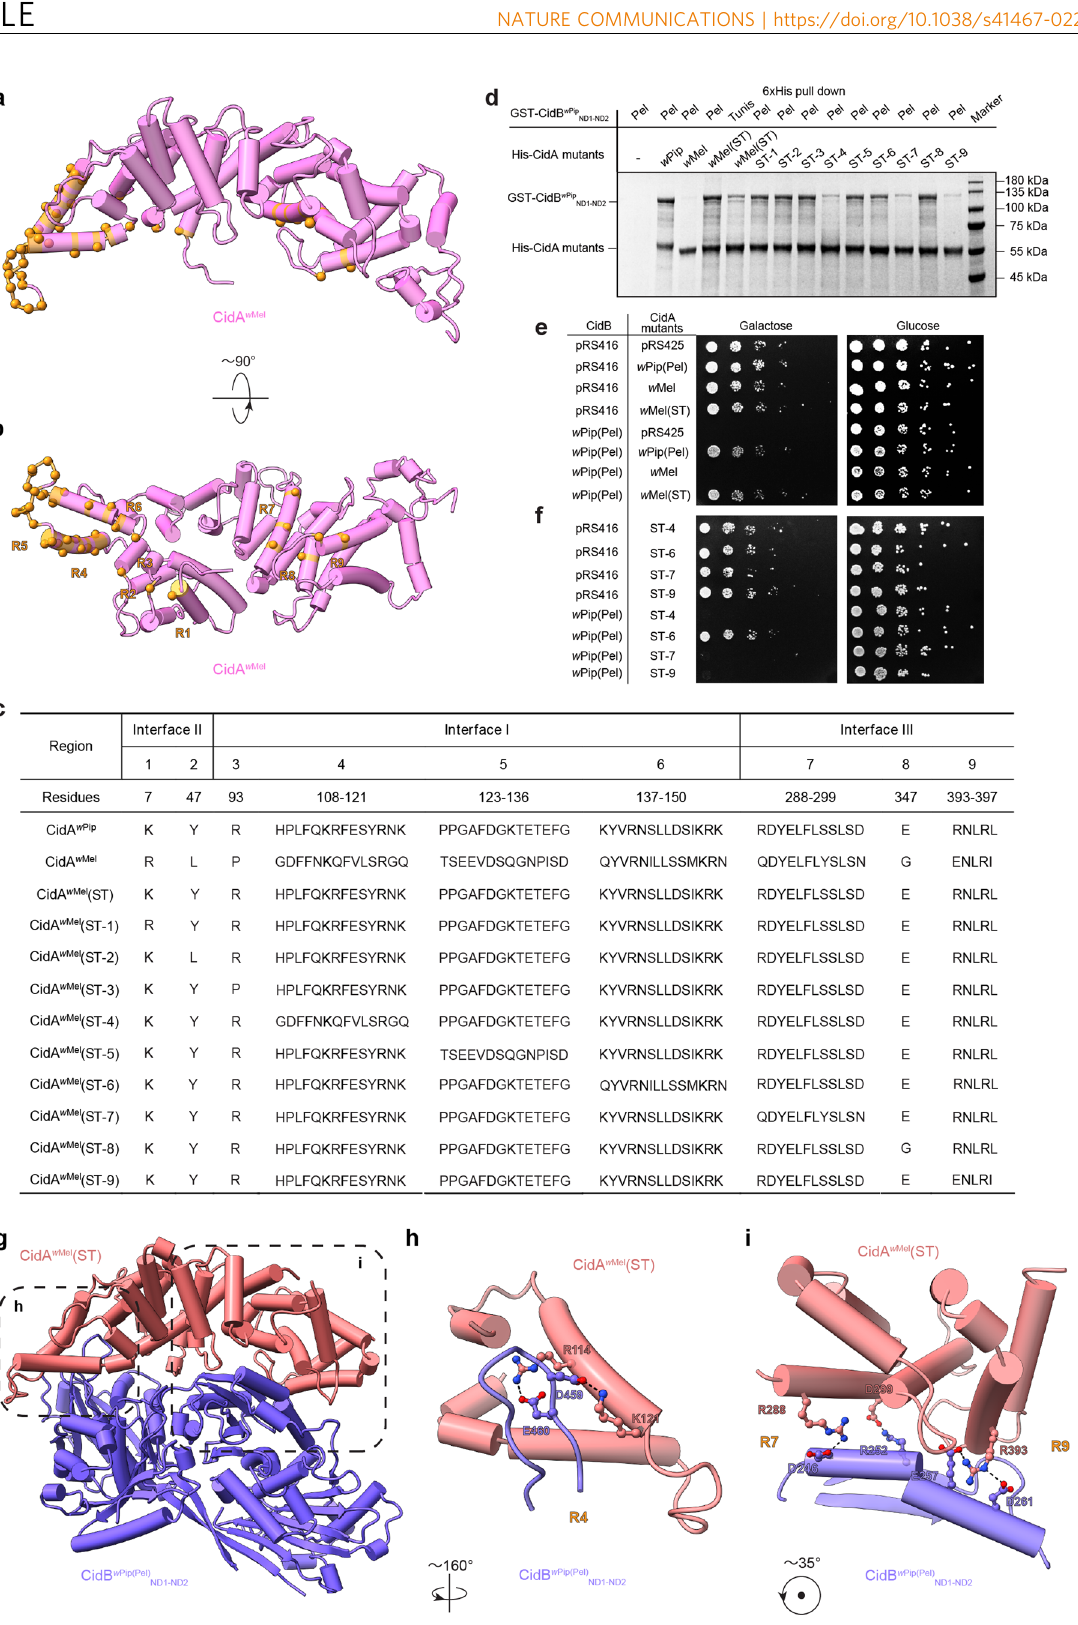
asparagine, respectively (Fig. 3c), which can no longer form salt bridges with D246 and R252 of CidB w Pip(Pel) ND1-ND2 . Finally, at region 9, residue R393 of CidA w Mel (ST) interacts with residues E257 and D261 of CidB w Pip(Pel) ND1-ND2 through salt bridges (Fig. 3i). In CidA w Mel (ST-9), residue 393 is glutamic acid (Fig. 3c), which cannot bind to E257 and D261 of CidB w Pip(Pel) ND1-ND2